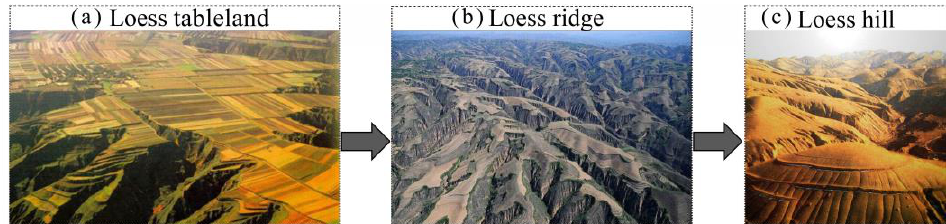
Figure 10. Schematic diagram of the development process of loess landforms. ( a ) diagram of the loess tableland; ( b ) diagram of the loess ridge; ( c ) diagram of the loess hill.